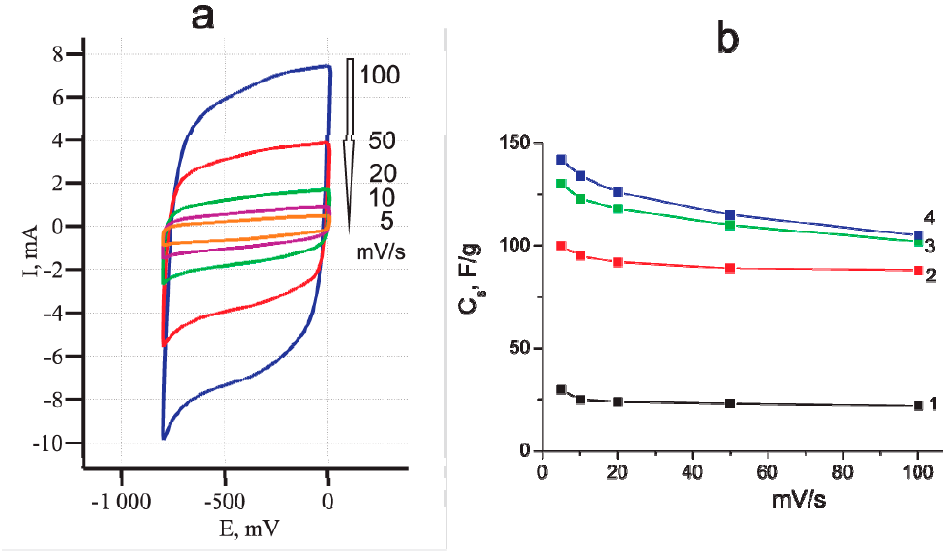
Figure 5. ( a ) CVs at the different scan rates. Working electrode was the MWCNT/Al foil oxidized at 5 V for 20 min; ( b ) the dependences of the specific capacity on the scanning rate. Oxidation time, min: 0 (trace 1); 10 (trace 2); 20 (trace 3); 30 (trace 4).